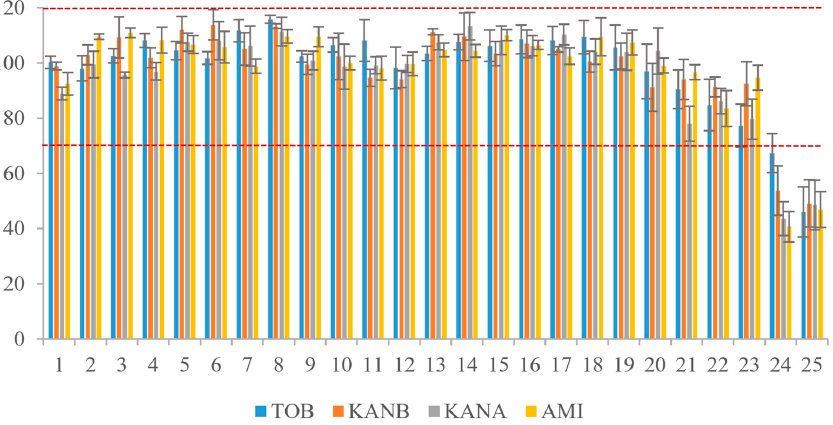
Figure 6. Reuse times of AAC. (Red dash lines reprensents the recoveries form 70% to 120%).